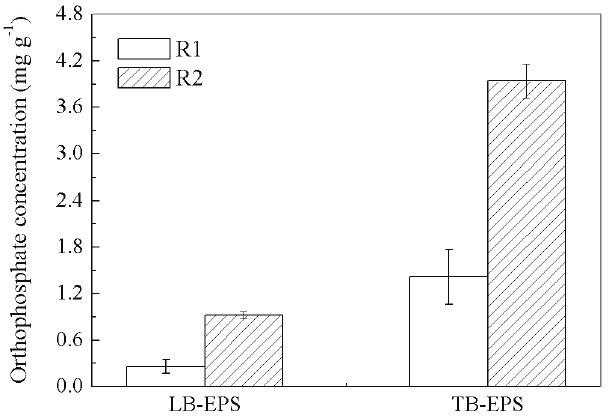
Fig. 3 – Orthophosphate content of LB-EPS and TB-EPS in reactors R1 and